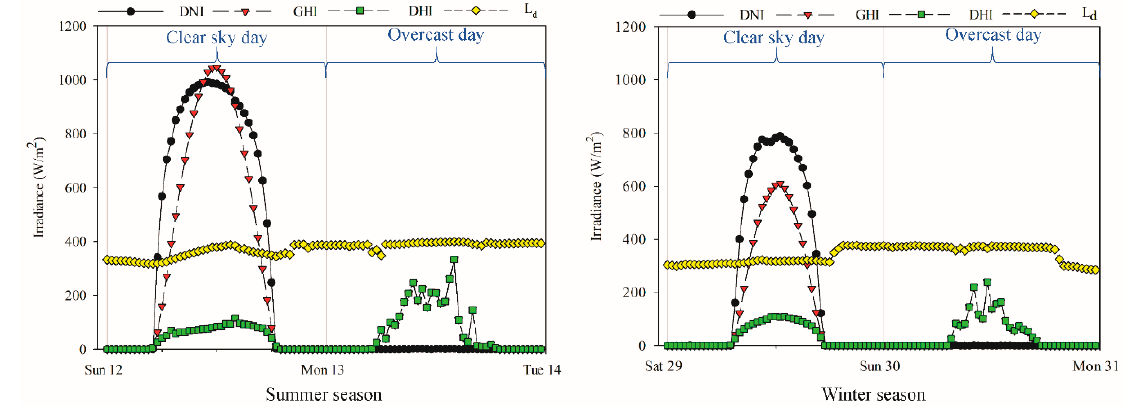
Figure 5. Typical seasonal clear sky and overcast solar radiation components distribution.